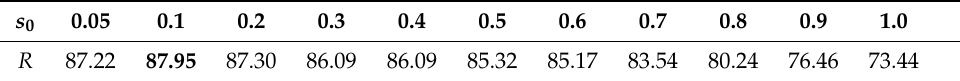
Table 1. Influence of truncating scale-space step-size s 0 for texture segmentation (best score in bold).